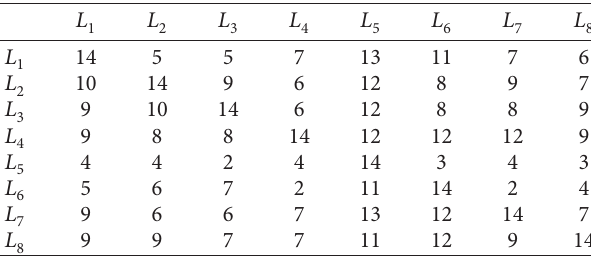
Table 3: The weighted comparison table in Example 3.